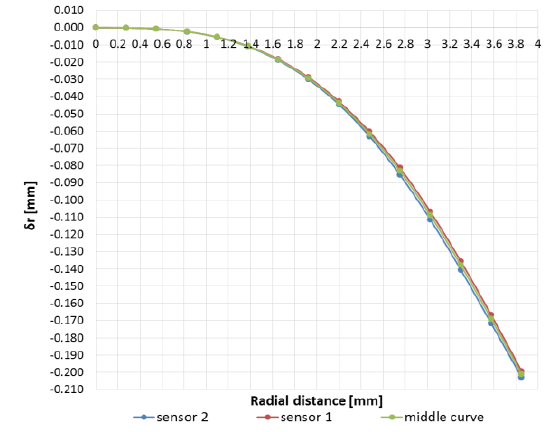
Figure 8 Radial Distortion Curves-